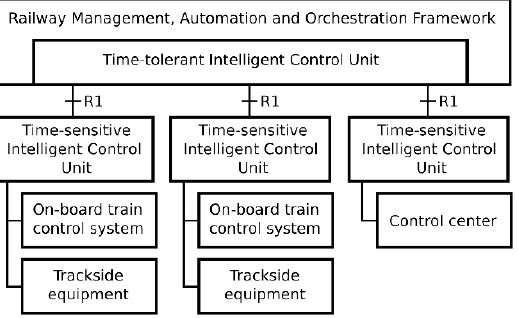
Figure 4. Deployment of time-tolerant and time-sensitive intelligence.